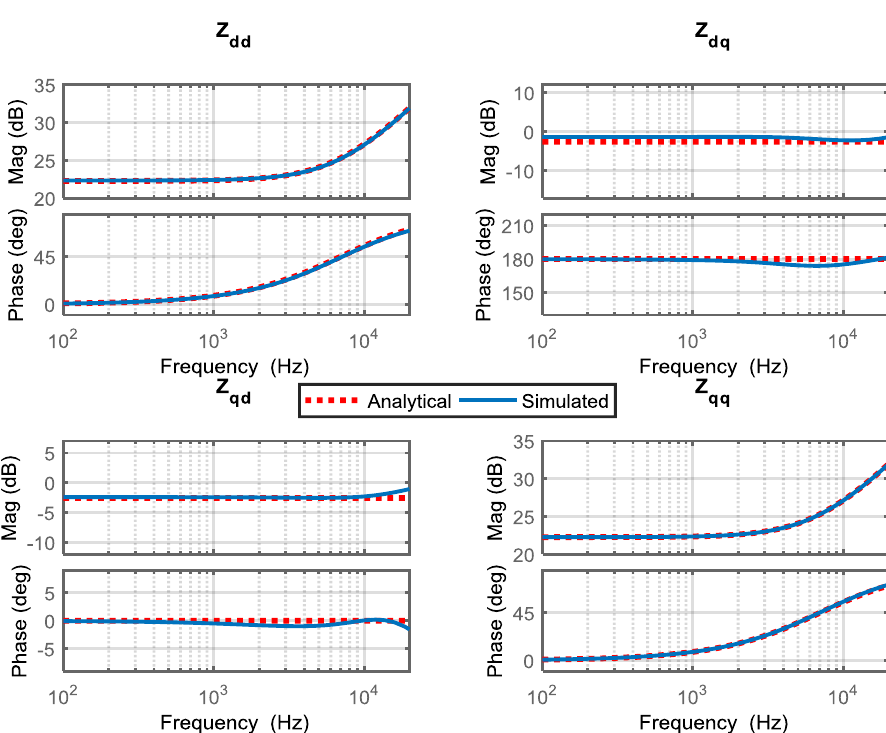
Figure 10. Comparison of Z -parameters for the simulated RL network with analytical results.